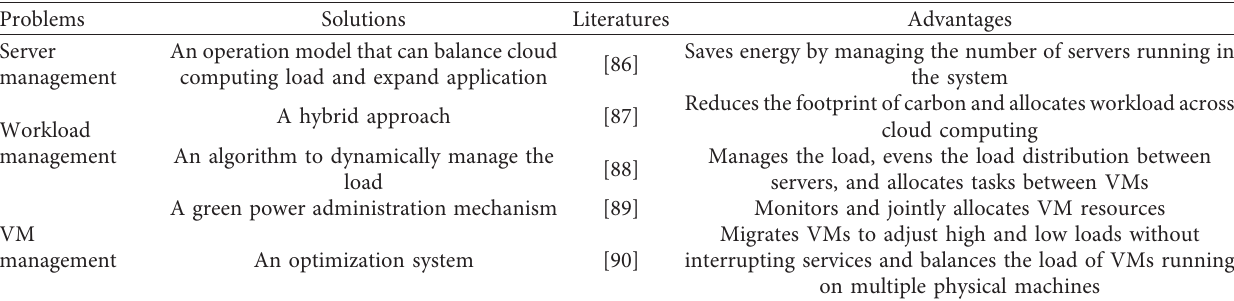
Table 6: Work summary of load balancing in cloud